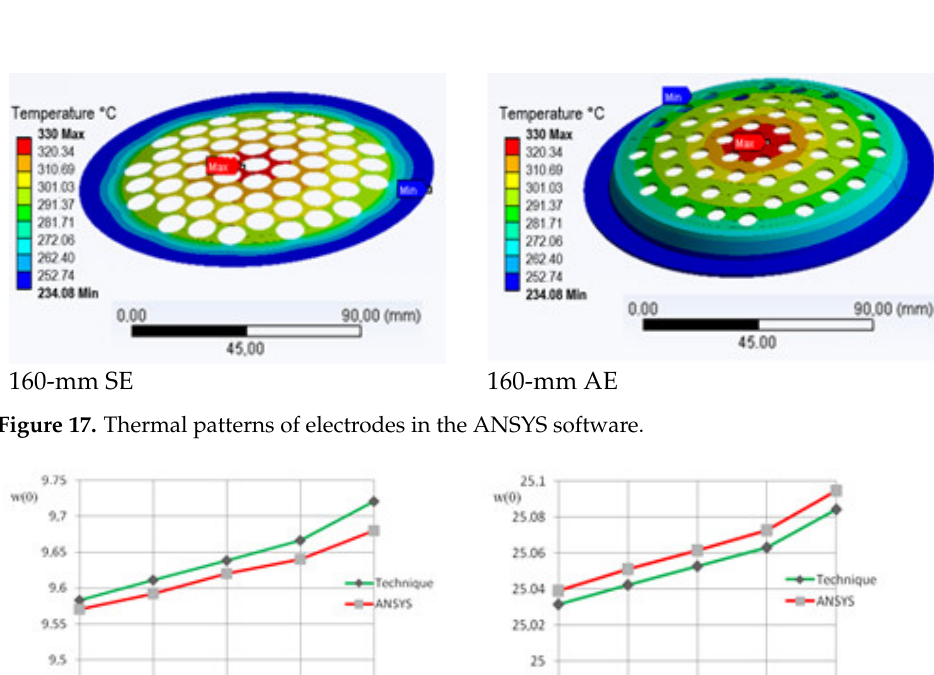
Figure 18. Electrode deflection w(0) as a function of temperature differential along the electrode radius calculated by simplified algorithm and in the ANSYS software.